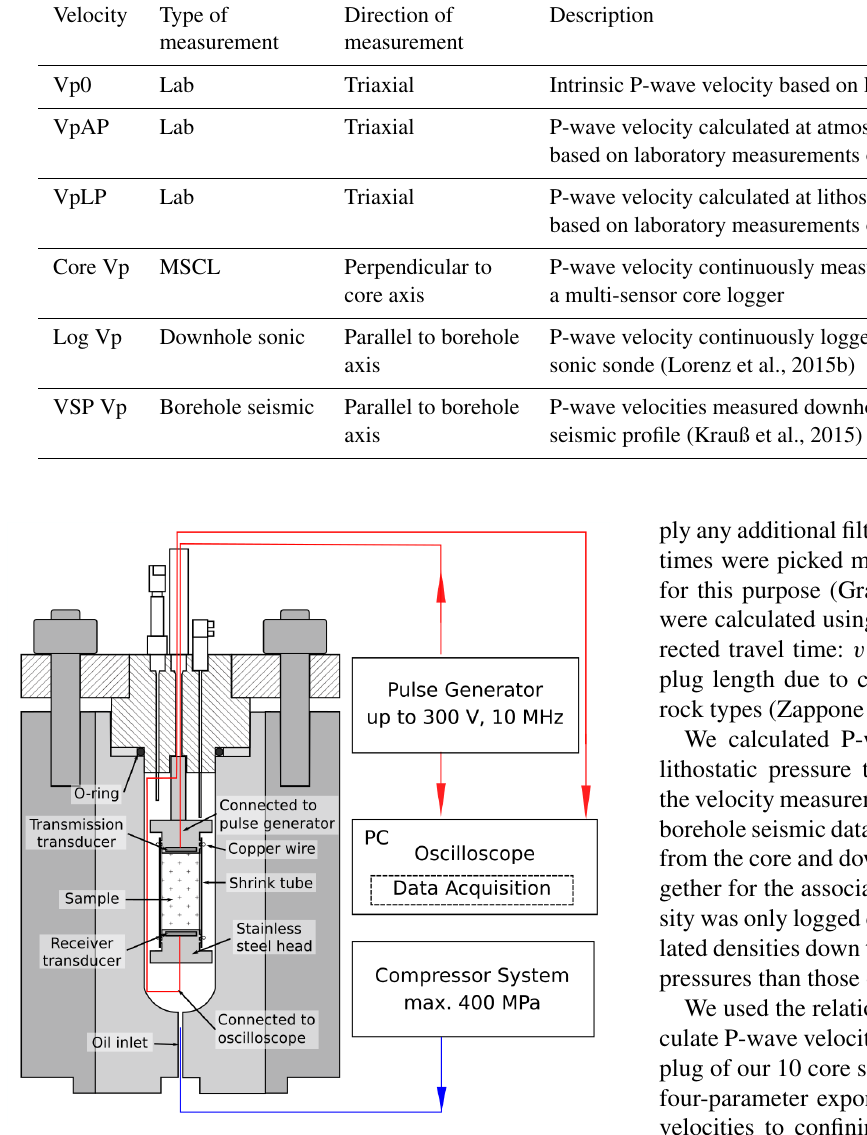
Figure 3. Schematic of the experimental setup used to determine the P-wave velocities under confining pressure. This setup comprises a pressure vessel with a sample chamber, pulse generator, compressor control, and PC-based acquisition unit. Placed inside the oil-filled pressure chamber there is the sample assembly (based on Barblan,